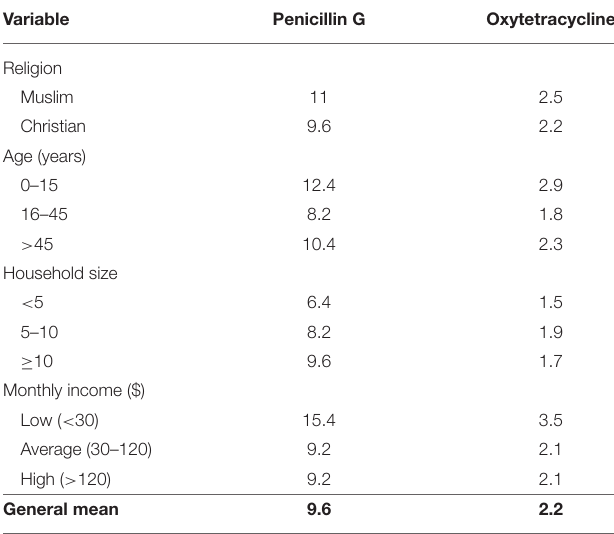
TABLE 3 | Risk (% of ADI) associated with the antibiotic residue intake in beef.